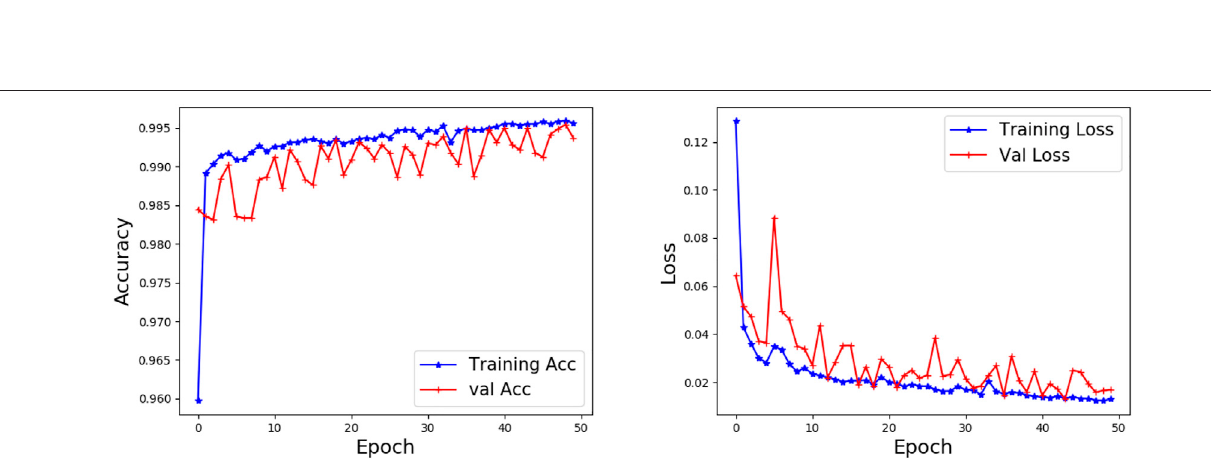
FIGURE 7 | Loss and accuracy performance of the initial model on KDD CUP 99 datasets.